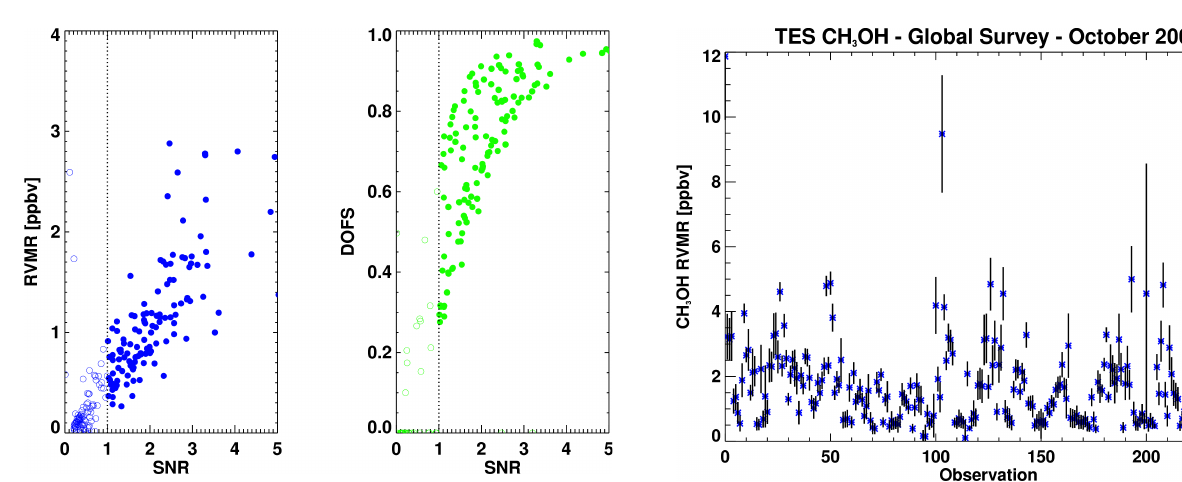
Fig. 10. Sequence of retrieved methanol RVMR values from TES for the October 2009 GS used in Fig. 9. The x-axis values are simply an index indicating order in time. The error bars include both noise and smoothing